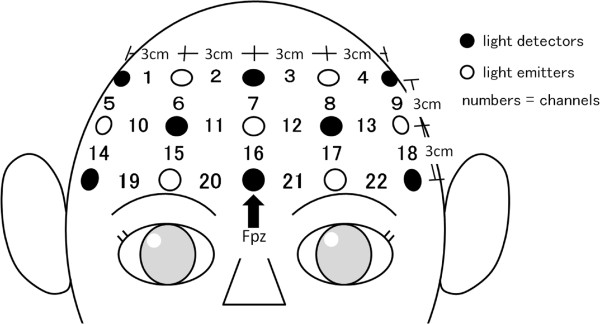
Placement of near-infrared spectroscopy probes and channels. The location of the light detector between channels 20 and 21 (indicated by black arrow) corresponds to FPZ of the electroencephalography 10–20 system.